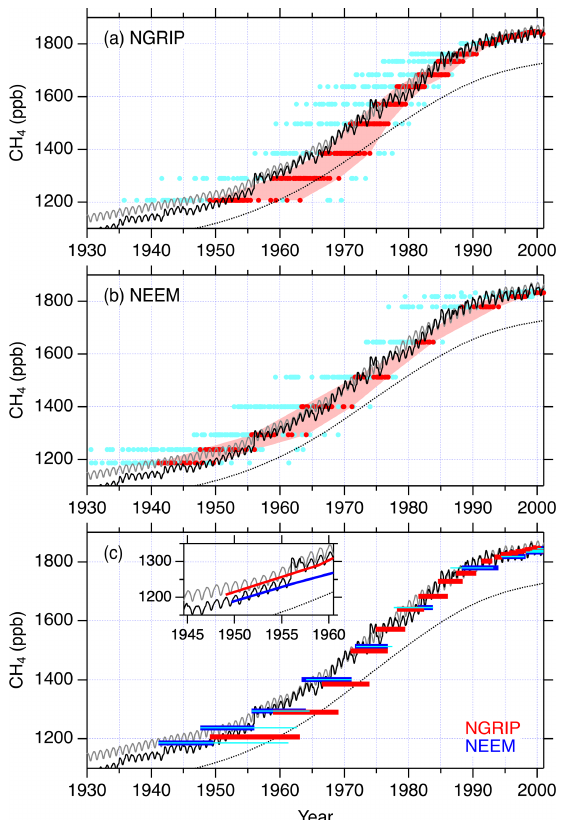
Figure 10. Results of reconstructions by the iterative dating method for the model cases with the 100 different diffusivity profiles (cir- cles coloured in the same manner as in Figs. 3, 6, and 8) from the (a) NGRIP and (b) NEEM firn air and (c) the ranges of reconstruc- tions from both firn sites. The red shades indicate the range of CH 4 mole fraction trends reconstructed using the diffusivity profiles that better reproduce the trace gases, except for CH 4 . Black and grey solid lines are the atmospheric CH 4 scenarios of BZ and CMIP6, respectively, and the black dotted line is the smoothed Antarctic CH 4 mole fraction (spline curve) from the Antarctic data shown in Fig. 1. The thick horizontal bars in red and blue in panel (c) corre- spond to red shades in panels (a) and (b) . The light blue thin bars in panel (c) indicate the range of the reconstructions for cases in which 14 CO 2 data are excluded for evaluations of the diffusivity profiles. The inset in panel (c) shows the magnified view of the NGRIP up- per bounds (red) and the NEEM lower bounds (blue) in comparison to the two